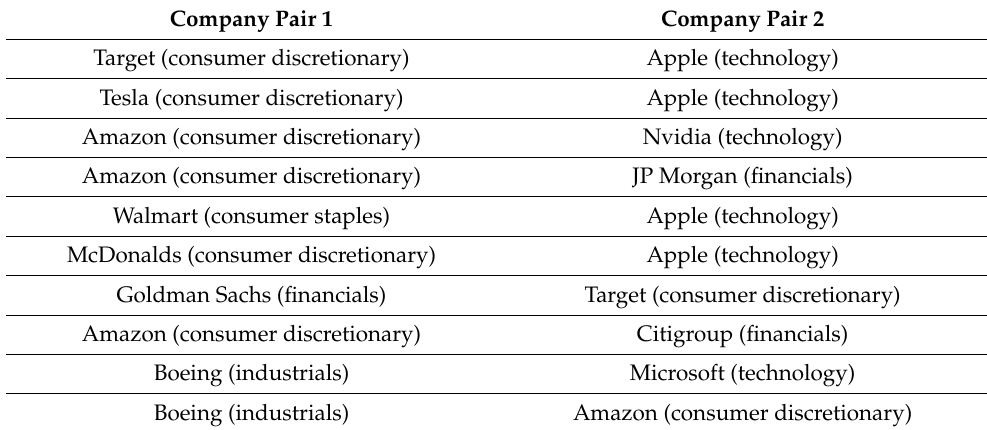
Table 5. Notable company pairs across sectors.